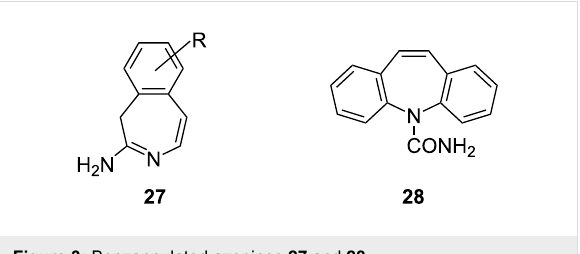
Figure 3: Benzannulated azepines 27 and 28 .